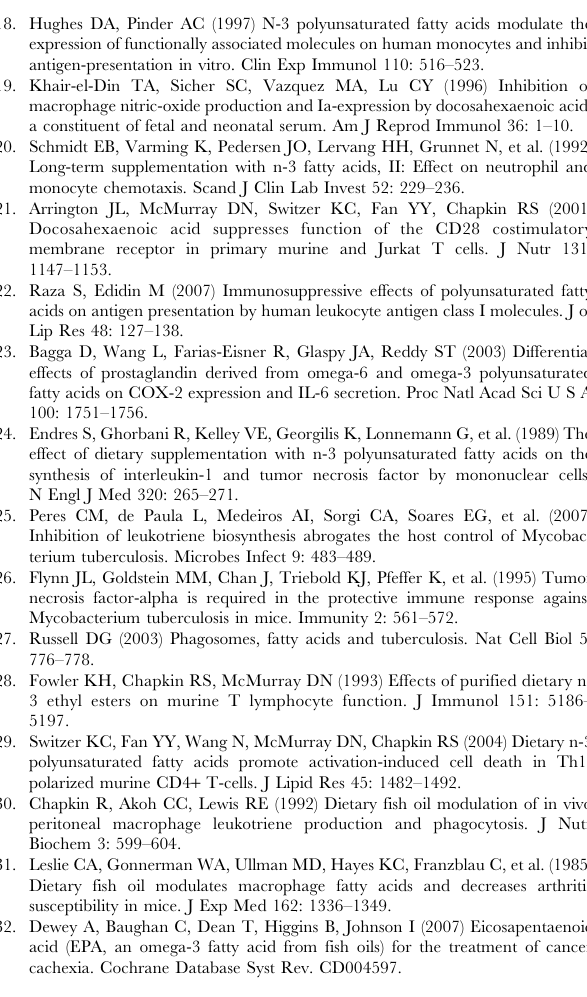
Figure S3 DHA impairs oxidative metabolism in infected J774A.1 cells activated with IFN c . Cells were incubated